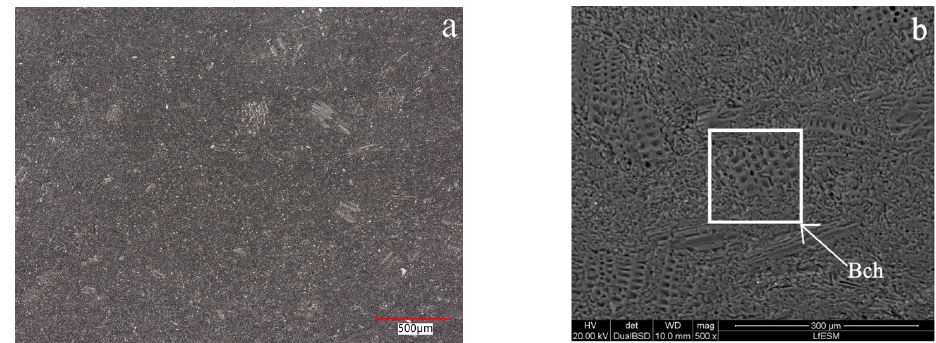
Figure 3. Images of the biochar sample. ( a ) Optical image of the biochar sample, magnification 100 × . ( b ) SEM image of the biochar sample with a spot of the EDS spectrum (Bch), magnification 500 × .